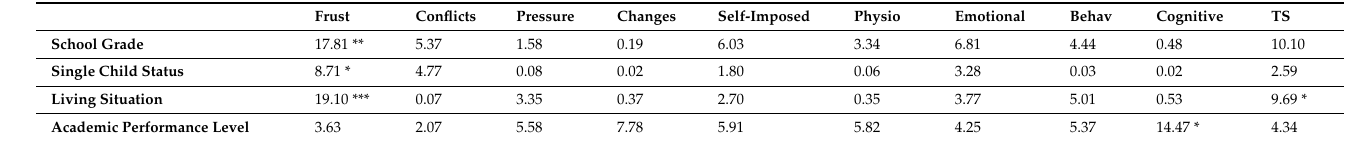
Table 3. Results of the multipair Kruskal–Wallis tests with academic stress dimensions as depen- dent variables and demographic information as single factors. Stress dimensions of interest were frustrations (Frust), conflicts, pressure, changes, self-imposed, physiological (Physio), emotional, behavioural (Behav), cognitive, and total stress (TS). (* p < 0.005; ** p < 0.001; *** p < 0.0001). Frust Conflicts